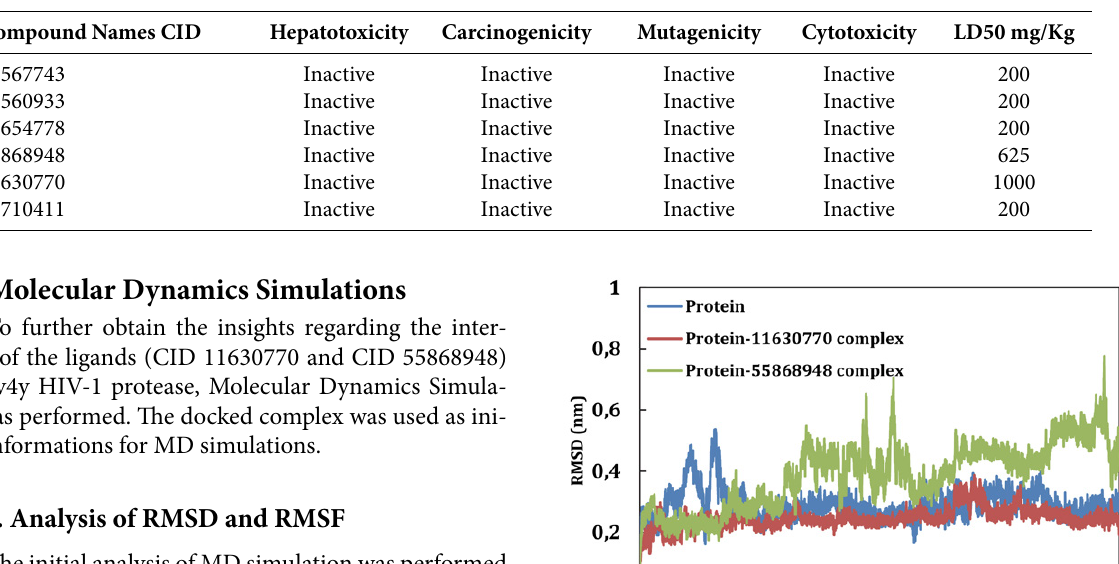
Table 7. Toxicity prediction of the selected compounds